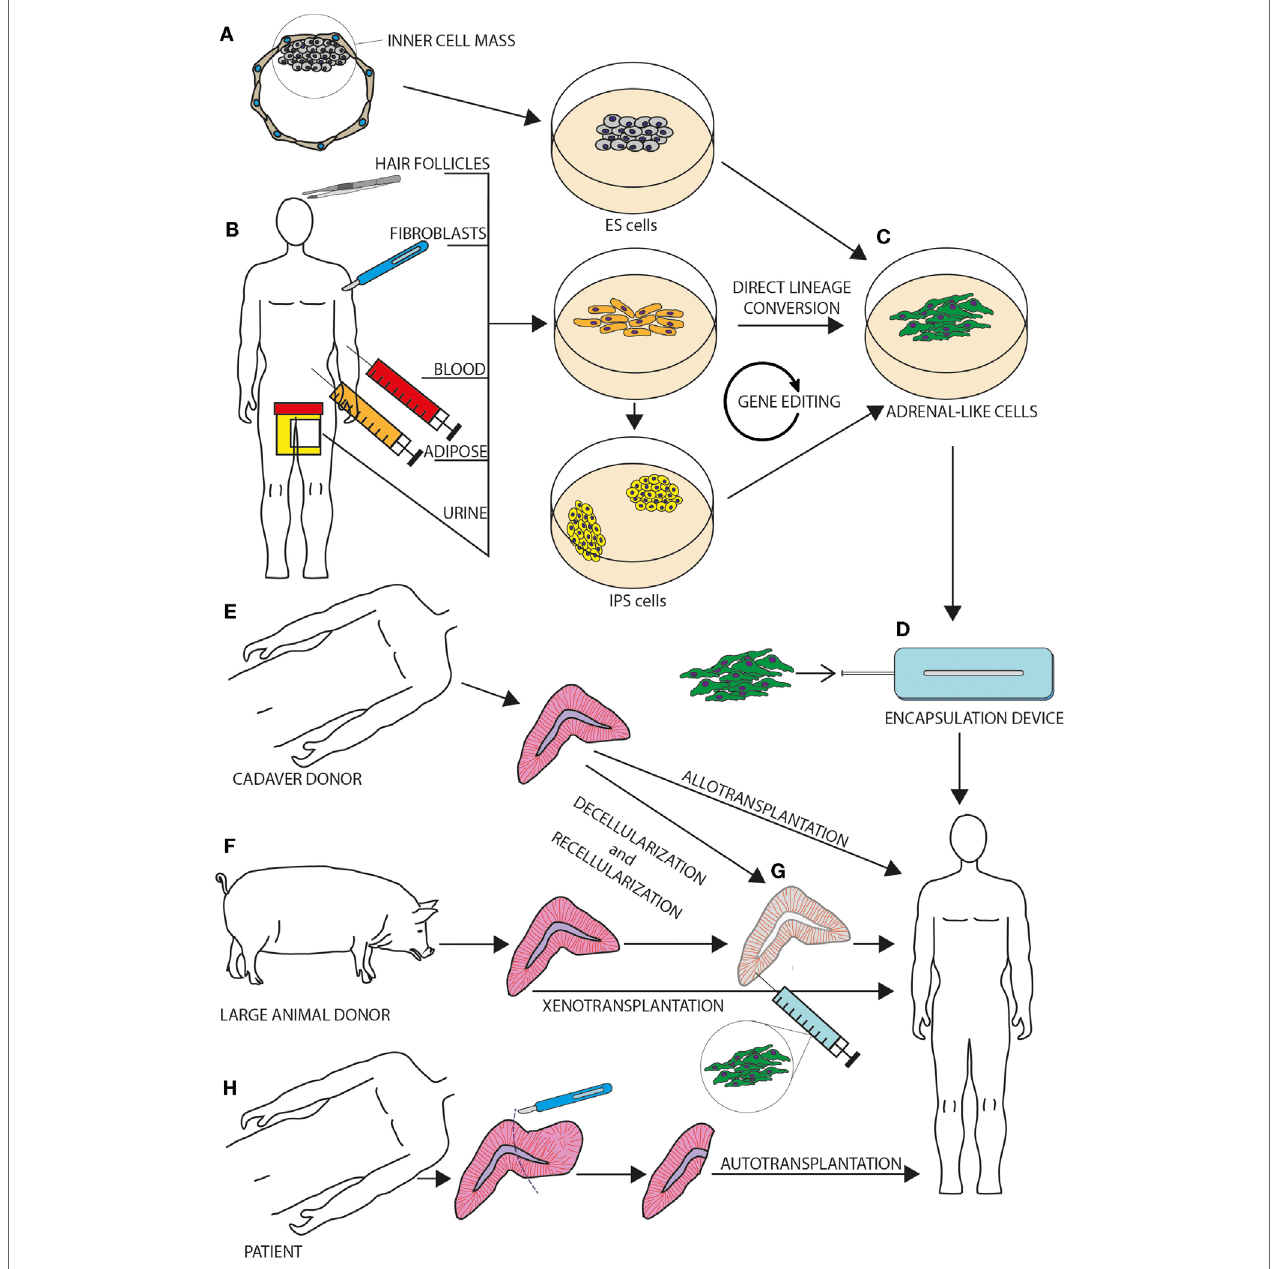
FiGURe 1 | This figure outlines novel and tested strategies for the treatment of adrenal insufficiency . Human embryonic stem (ES) cells (A) as well as somatic cells (such as fibroblasts, hair follicle dermal papillae, adipose tissue-derived stem cells, and urine-derived stem cells) established from human donors (B) can be cultured in vitro and induced to acquire an adrenocortical phenotype (C) through specific differentiation protocols. A gene-editing step can be included in case of monogenic